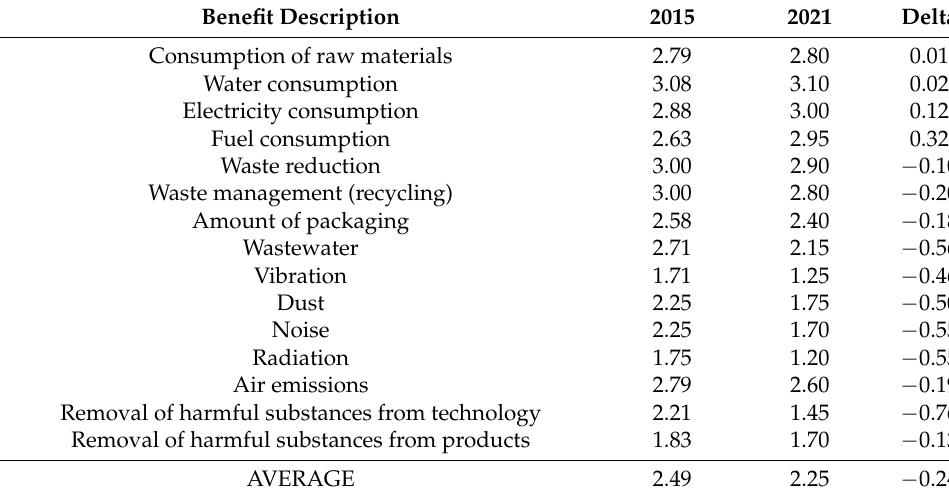
Table 7. Ecological and environmental benefits of